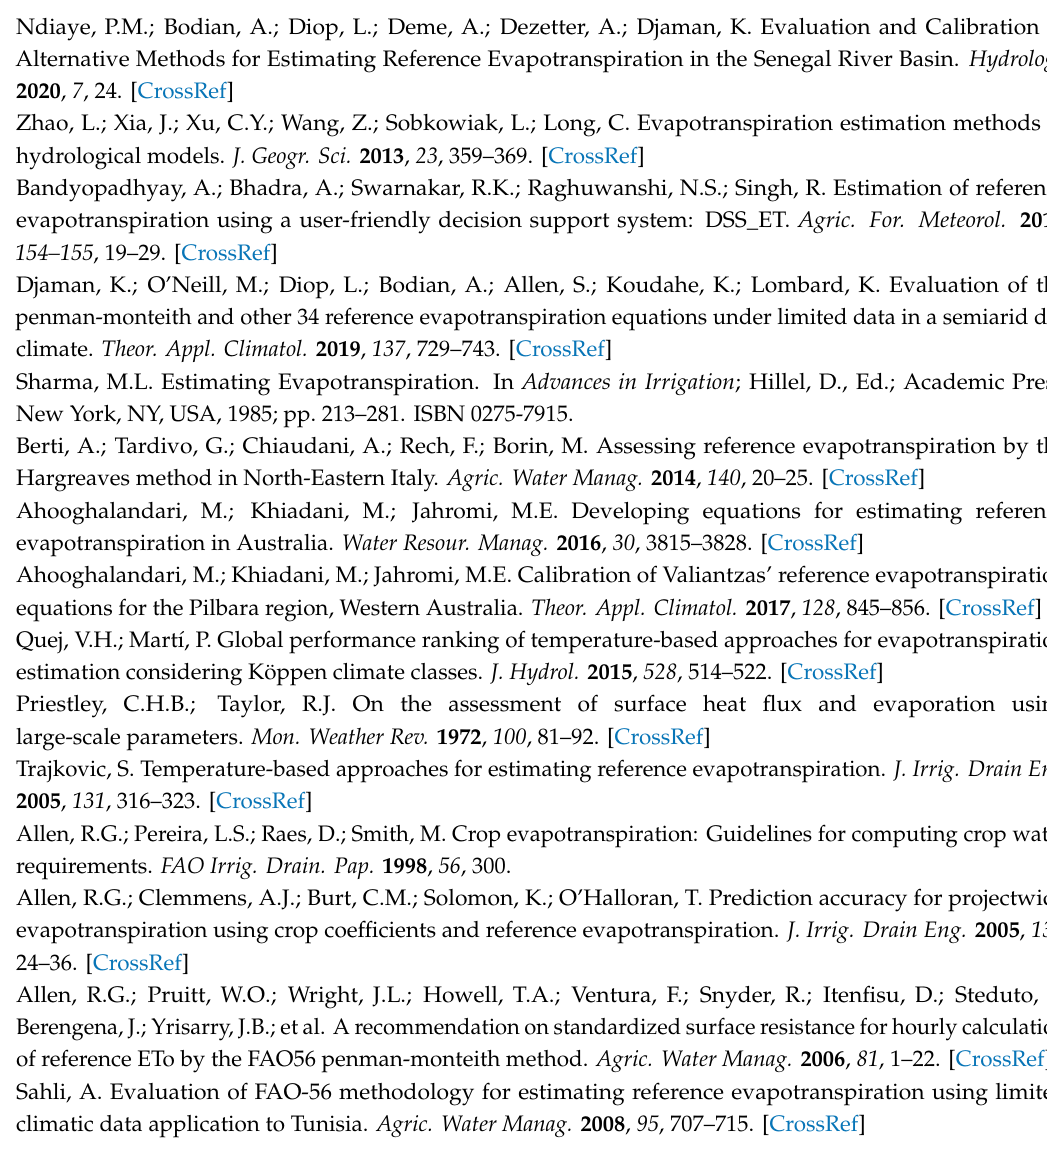
Table S1: A summary of mean statistical metrics averaged for each river basin before calibration. Table S2: Regression coe ffi cients ( Ψ ) used to calibrate and validate the 13 ET0 models on a monthly